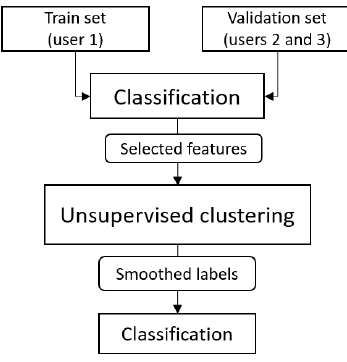
Figure 8. Clustering